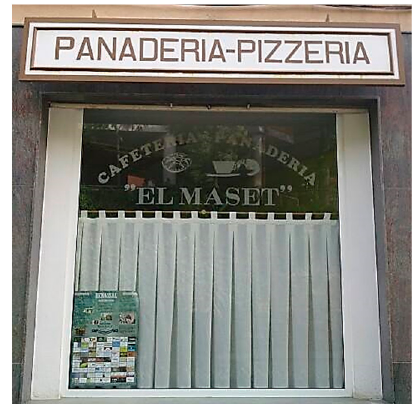
Figure 26. Benasal: Valencian-only sign on a bakery .